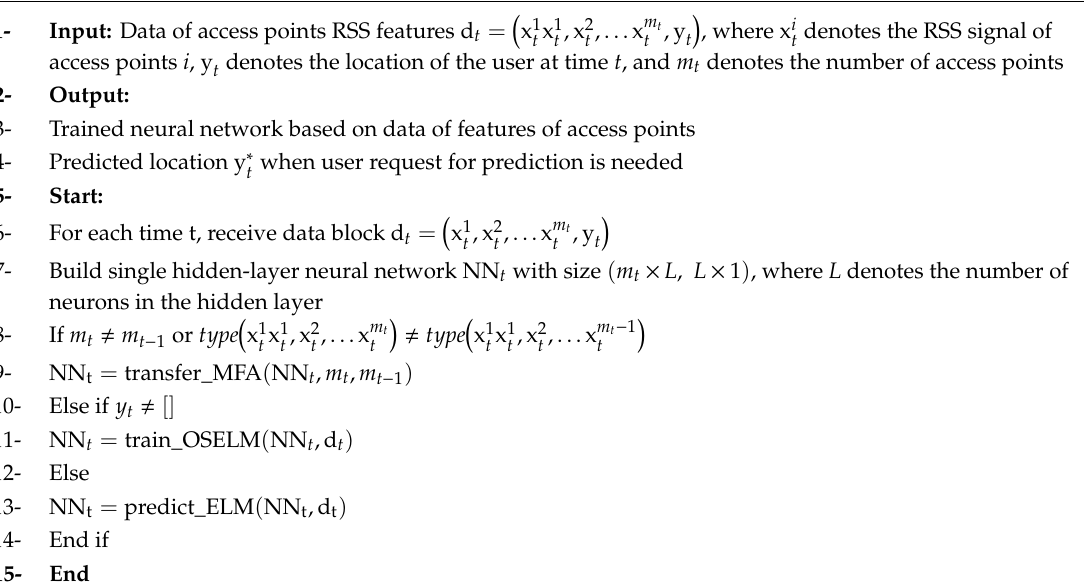
Algorithm 1. Procedure of the maximum feature adaptive online sequential extreme learning machine (MFA-OSELM) for WiFi